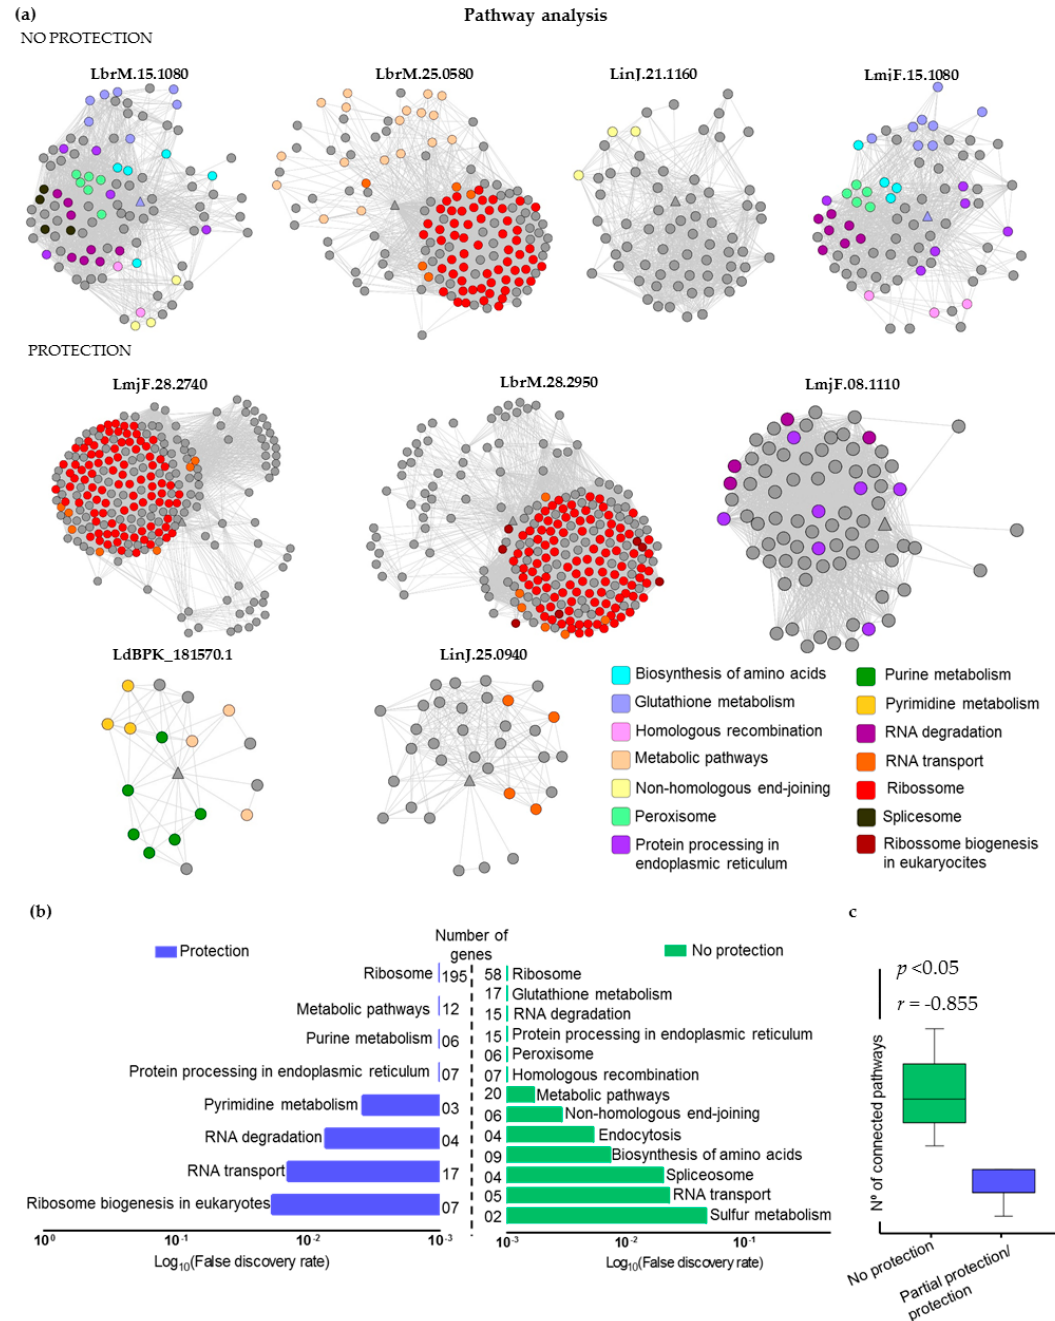
Figure 3. Immunogenic proteins mapped in Protein-Protein Interaction (PPI) networks: ( a ) PPI networks constructed starting with the target proteins (“no protection” and “partial protection/protection”) represented by triangles and specific pathways associated with each node (circles) using KEGG database. ( b ) Analysis of KEGG enriched pathways was performed by False Discovery Rate. For both “no protection” and “partial protection/protection”, the bar shows the fold-enrichment of the pathways. ( c ) Significant correlation between number of pathways connected with the target proteins of “no protection” and “partial protection/protection” groups ( p = 0.007).